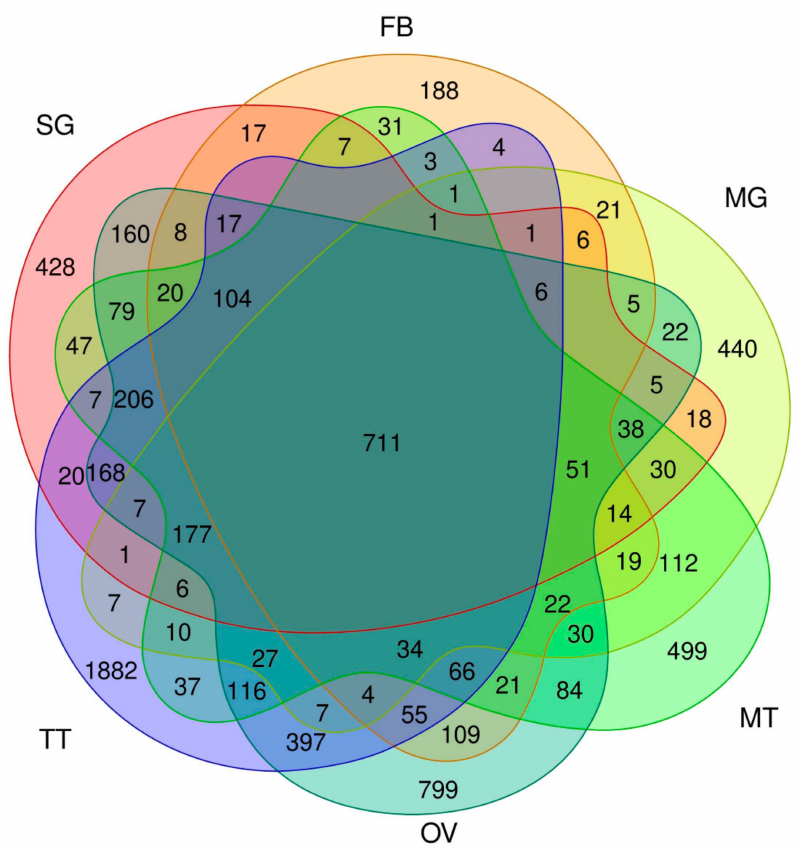
Figure 5. Venn diagram showing the transcripts expressed in each tissue. The number of transcripts with a tpm value > 30 is shown. SG—silk gland; FB—fat body; MG—mid gut; MT—Malpighian tubules; OV—ovary; TT—testis.